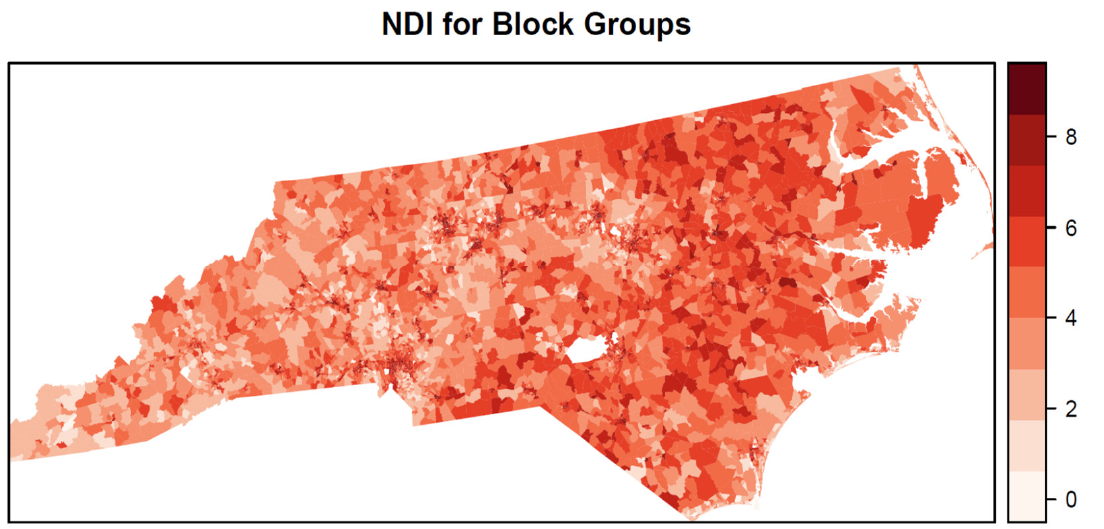
Figure 5. Neighborhood disadvantage index for block groups estimated from the Bayesian shared component index model.